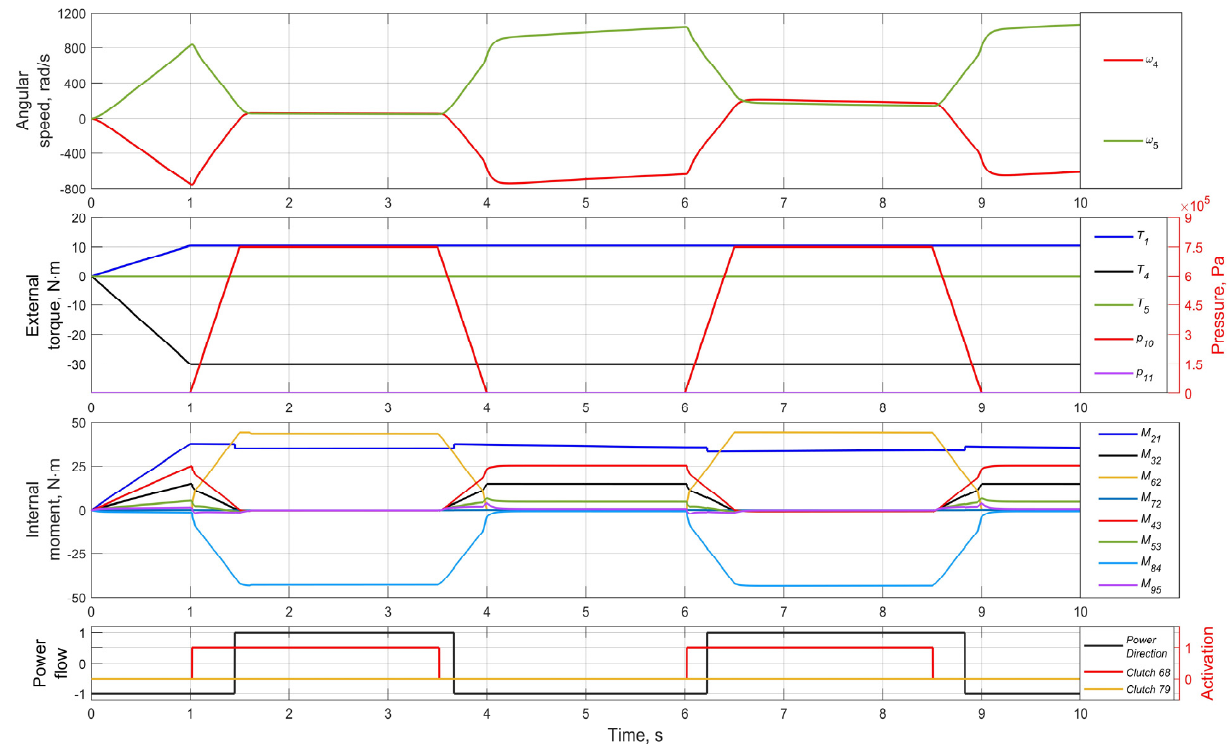
Figure 9. Simulation of transmitting all the torque through one output axle.